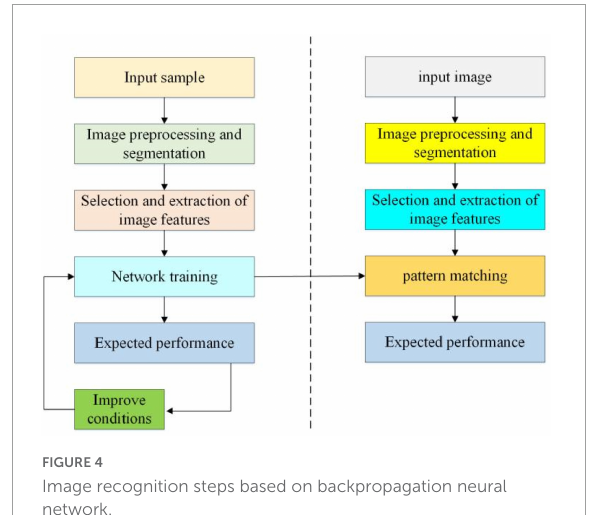
FIGURE4 Image recognition steps based on backpropagation neural